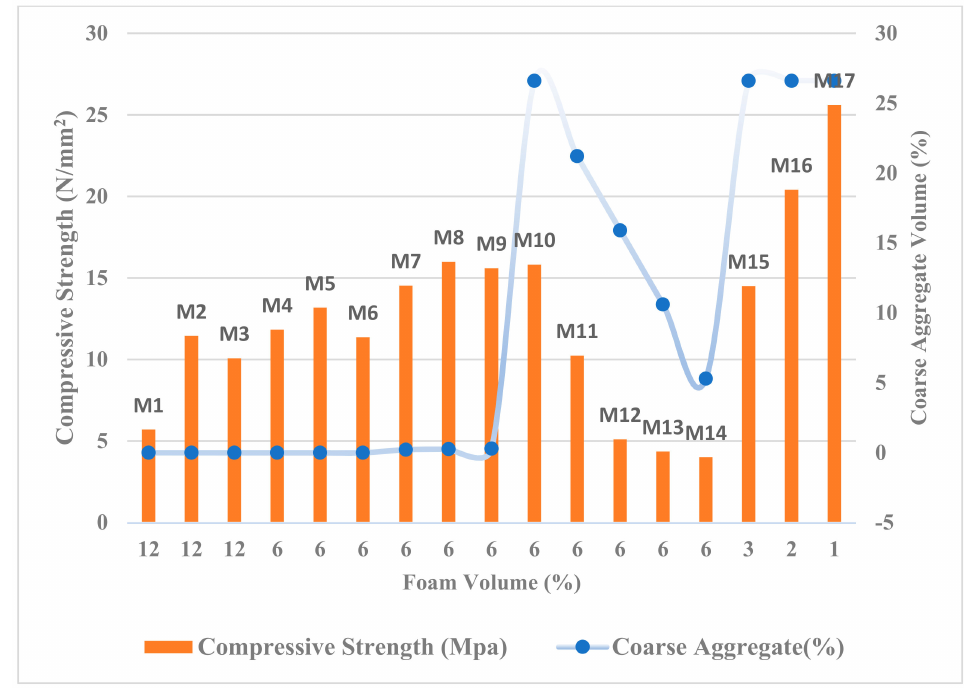
Figure 9. Compressive Strength vs. Coarse Aggregate vs. Foam Volume of FC.